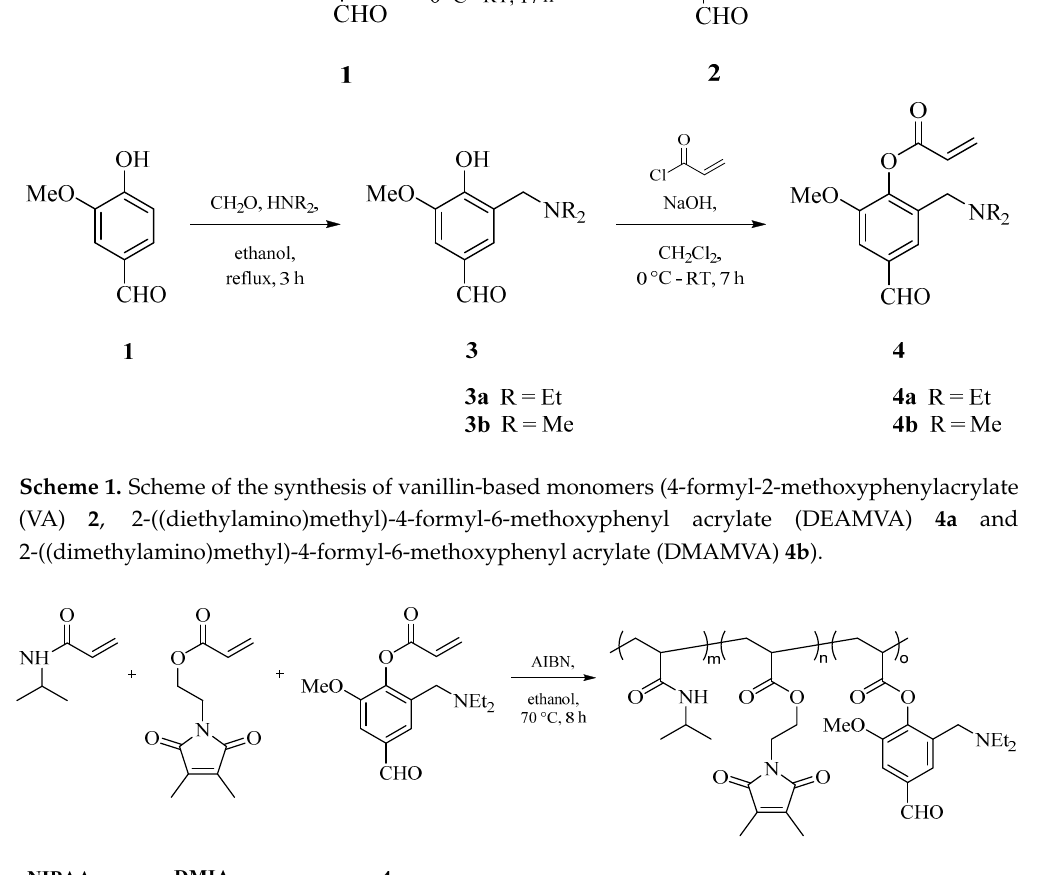
Scheme 2. Scheme of the synthesis of the respective photo cross-linkable polymers with vanillin- based monomer DEAMVA. NIPAAm, N -isopropyl acrylamide; DMIA, dimethylmaleimidoacrylate.